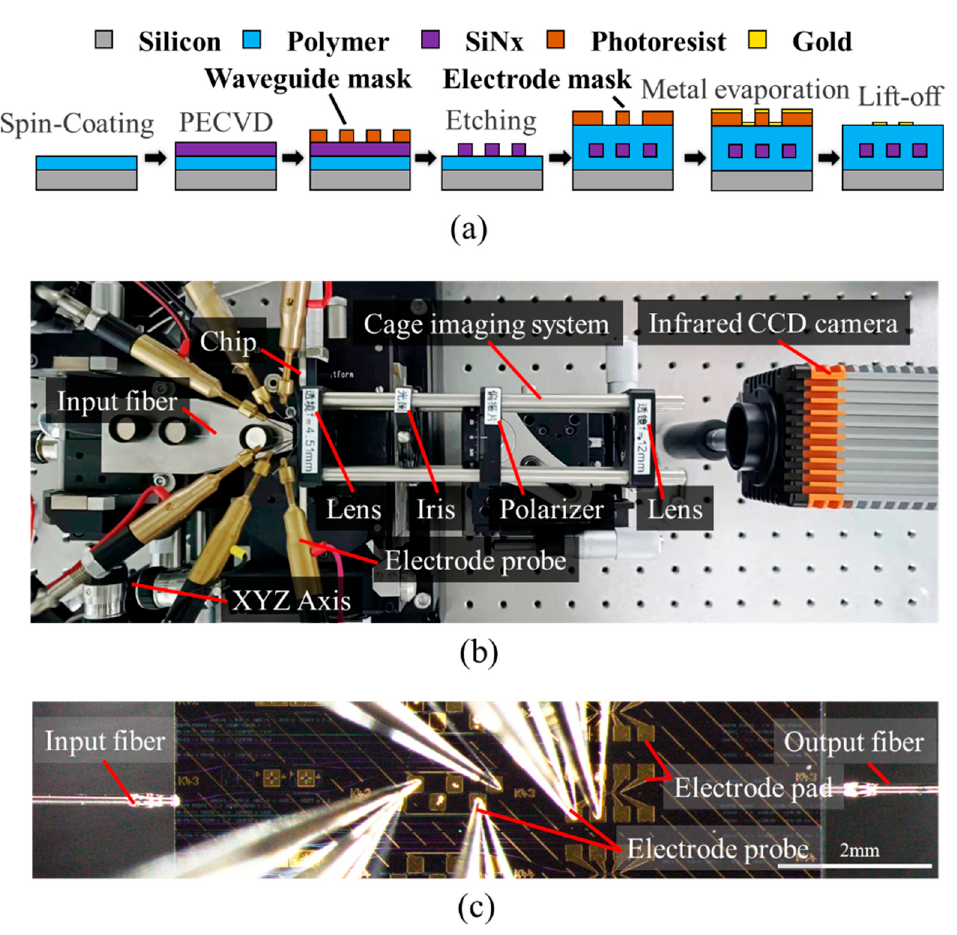
Figure 3. ( a ) Flow of the fabrication process. ( b ) Photo of the imaging experimental setup. ( c ) Photo of the fiber-chip-fiber alignment and transmission system. The electrodes are contacted by needle probes.